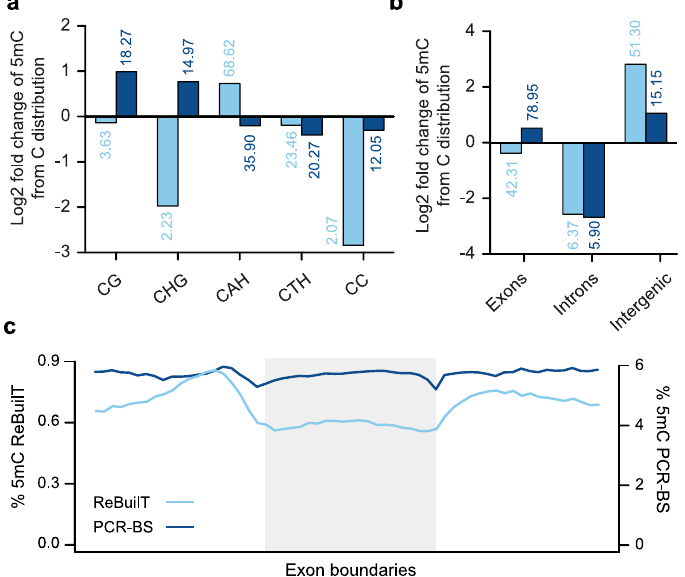
Fig 4. Cytosine methylation in P. berghei . (a) The log2 fold change of 5mC contexts from cytosine contexts within the P. berghei genome. Each bar is annotated with the percentage of 5mC loci within the context. The sequence context varies greatly between PCR-free and amplified samples. ReBuilT data reveals an enrichment in the asymmetric CAH context, and CHG and CC contexts are strongly disfavoured. PCR-BS methylation occurs more often in CG and CHG contexts (H = A, T, G). (b) The distribution of methylation across genomic regions, shown as log2 fold change from the distribution of cytosines. The percentage of 5mC loci in the regions is given above each bar. Methylation in the AT-rich intergenic regions is underrepresented in the PCR-BS dataset. (c) The profile of 5mC levels over exons. Traditional PCR-BS gives a similar profile to ReBuilT, but greatly over-estimates the 5mC